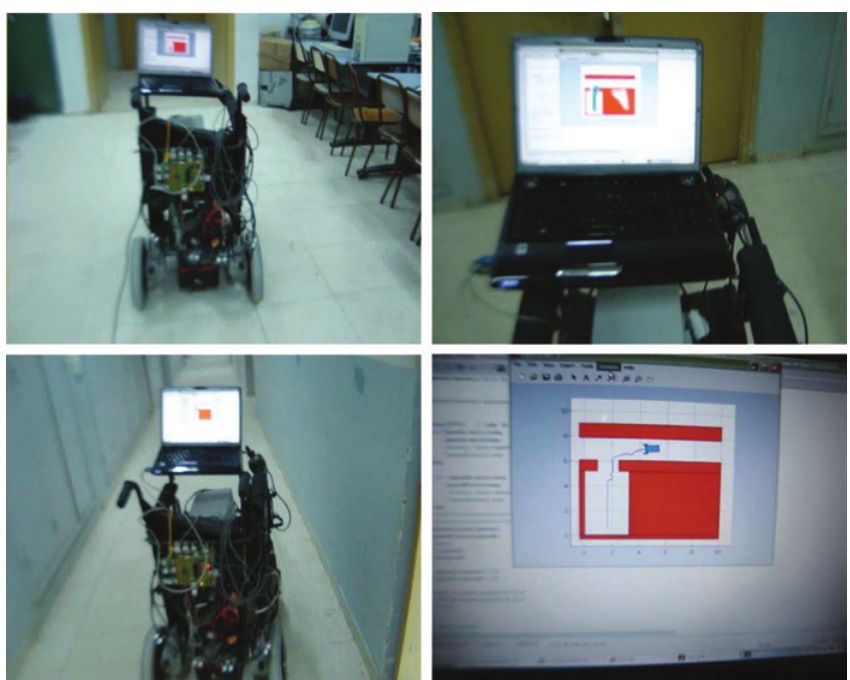
Figure 16: Picture of the Wheelchair When Navigating in a Real Environment.